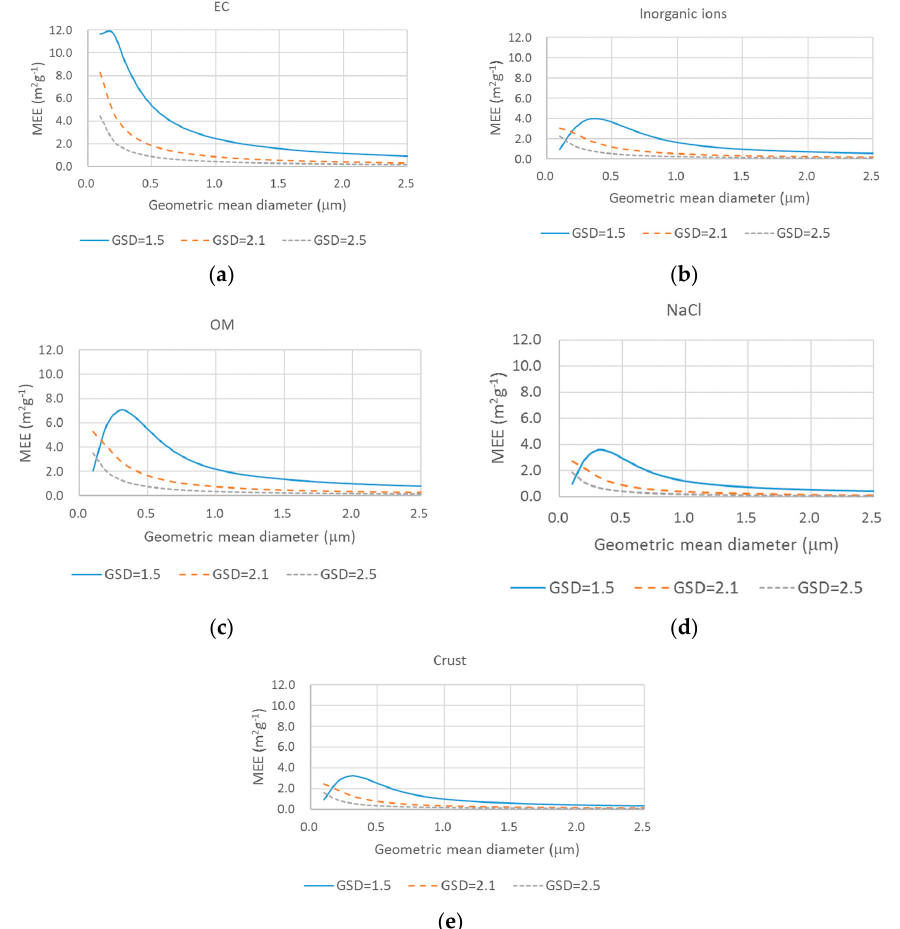
Figure 3. Composition-based mass extinction efficiency as a function of the geometric mean diameter for different geometric standard deviations for ( a ) elemental carbon (EC), ( b ) inorganic ions, ( c ) organic matter (OM), ( d ) NaCl, and ( e ) Crust.